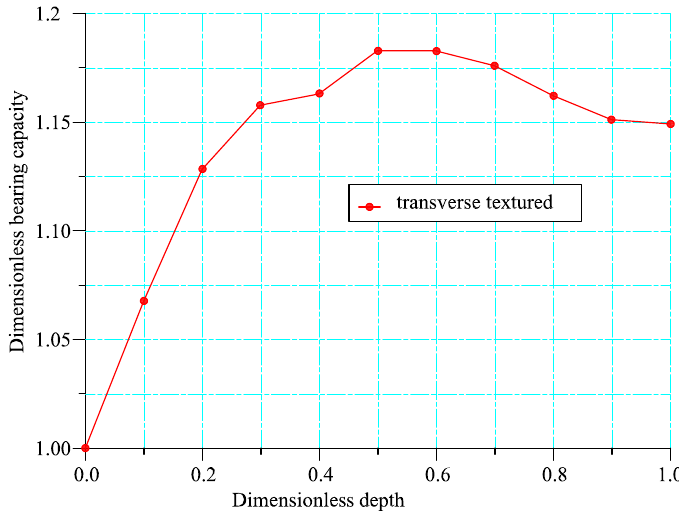
Figure 15. Influence of transverse texture depth on dimensionless LCC.